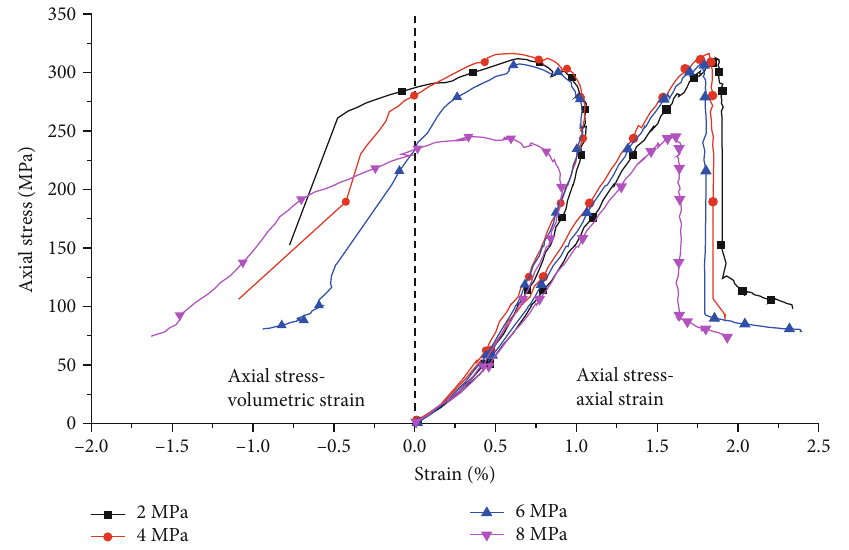
Figure 4: Stress strain curves of Beishan granite under di ff erent pore pressures [40]. Table 3: Permeability evolution under di ff erent pore